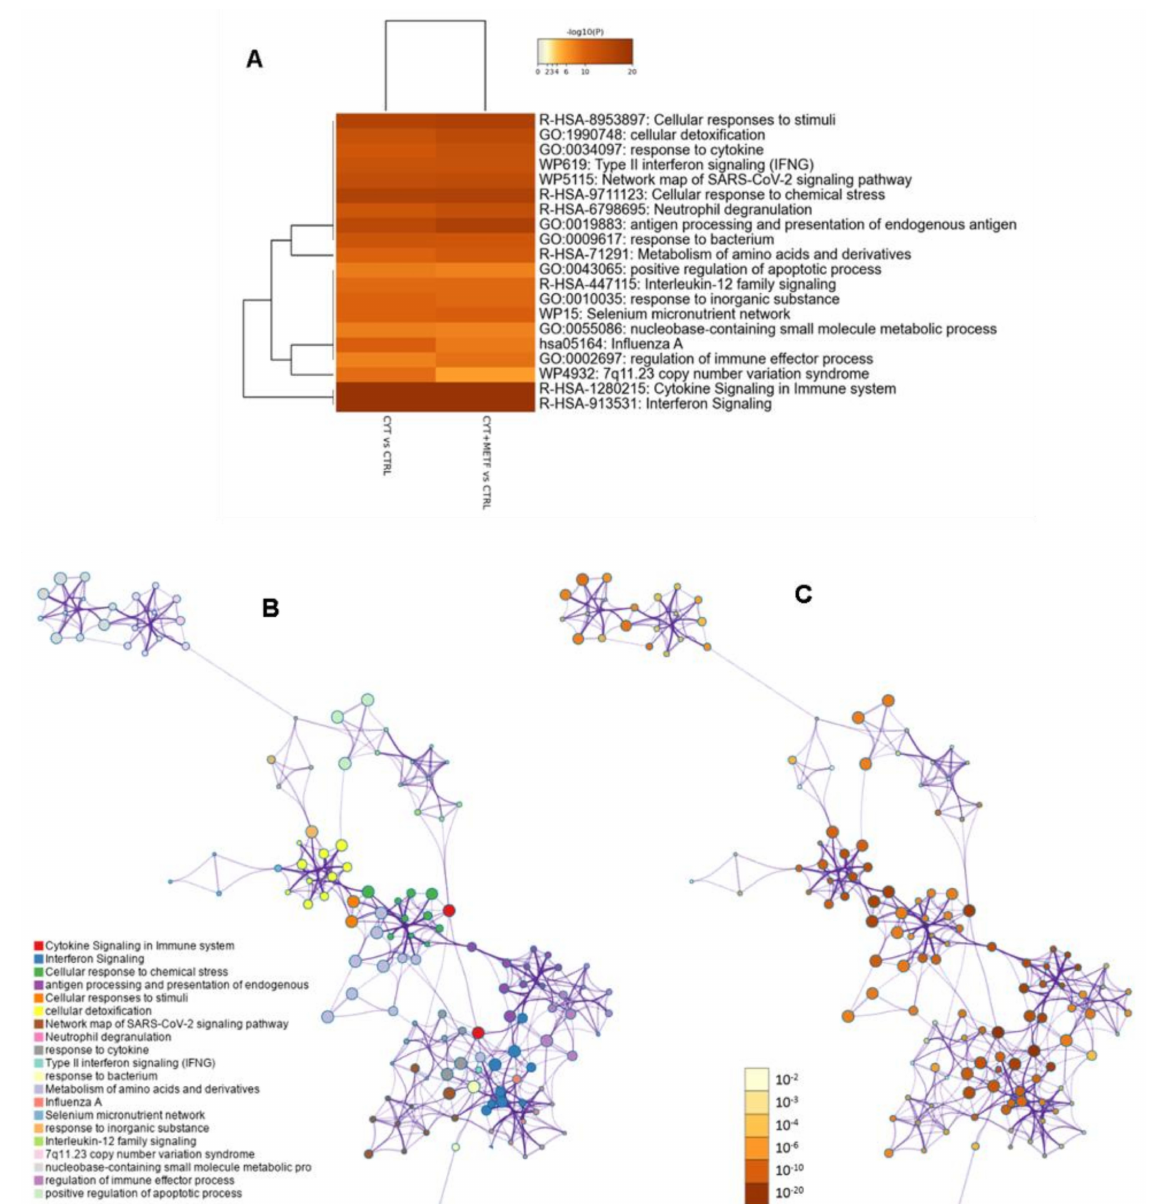
Figure 4. Enrichment analysis results for biological process. ( A ) All statistically enriched terms were identified and used for filtering, after computing the accumulative hypergeometric p -values and enrichment factors. The remaining significant terms were then hierarchically clustered into a tree based on Kappa-statistical similarities among their gene memberships. Then a 0.3 kappa score was applied as a threshold to divide the tree into term clusters. The term with the best p -value within each cluster was selected as its representative term and displayed in a dendrogram. The heatmap cells are colored by their p -values. ( B ) A subset of representative terms from the full cluster were selected and converted into a network layout. Each term is represented by a circle node, where its size is proportional to the number of input genes fall into that term, and its color represent its cluster identity (i.e., nodes of the same color belong to the same cluster). Terms with a similarity score >0.3 are linked by an edge (the thickness of the edge represents the similarity score). The network was visualized with Cytoscape (v3.1.2) with “force-directed” layout and with edges bundled for clarity. One term from each cluster was selected to have its term description shown as a label. ( C ) The same enrichment network has its nodes colored by p -value, as shown in the legend. The darker the color, the more statistically significant the node